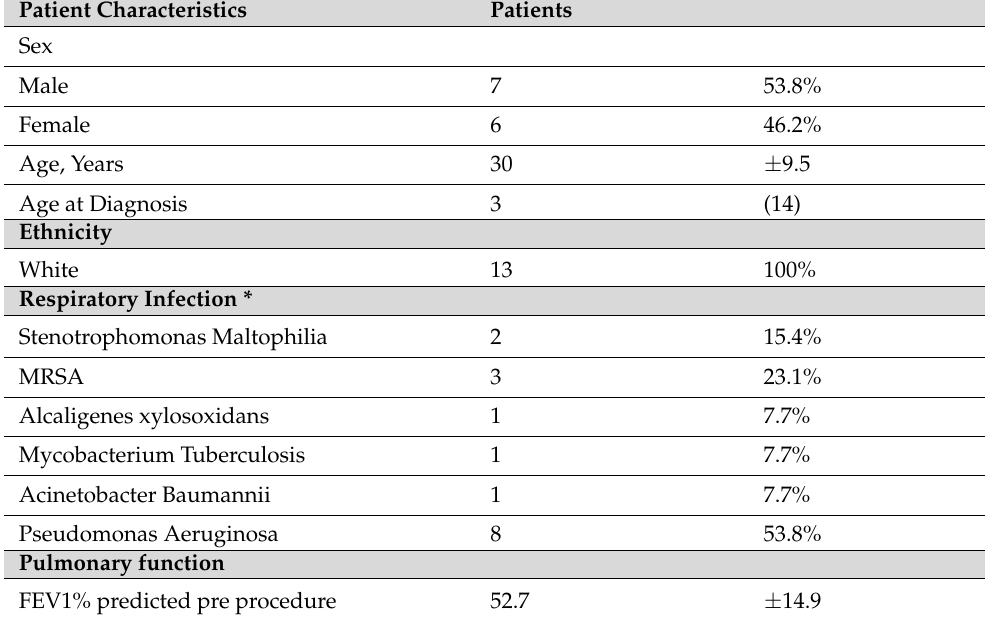
Table 1. Characteristics of the patients at the first hemoptysis episode requiring bronchial artery embolization (n =